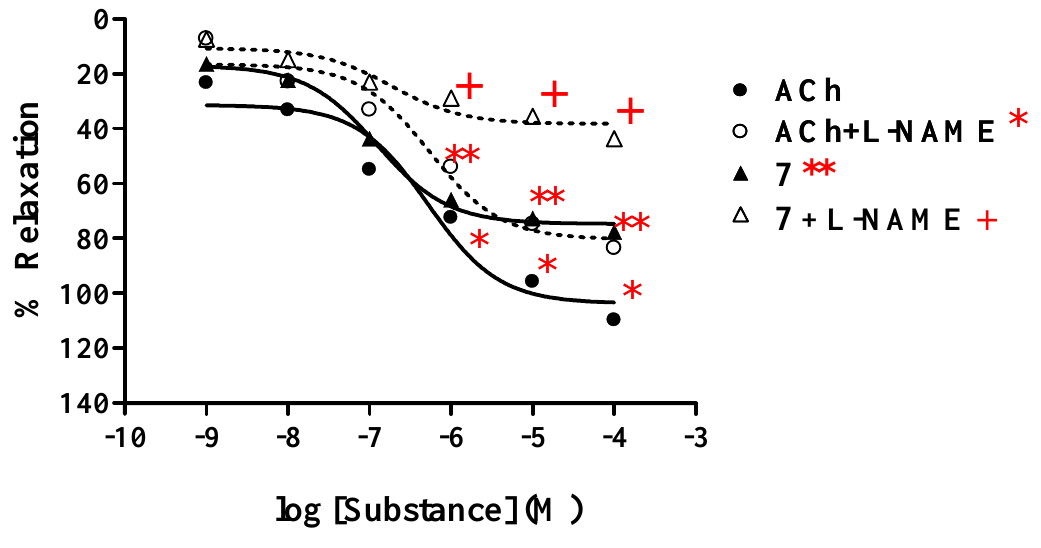
Data represented as mean ± s.e.m. of six experiments, each performed in duplicate. *p < 0.05, ACh versus ACh+ L -NAME, **p < 0.05, ACh versus 6 , + p < 0.05, 6 versus 6 + L -NAME. Figure 4. Effect of 7 on the vascular function of rat thoracic aorta in the presence of L -NAME (1 mM) compared with ACh.